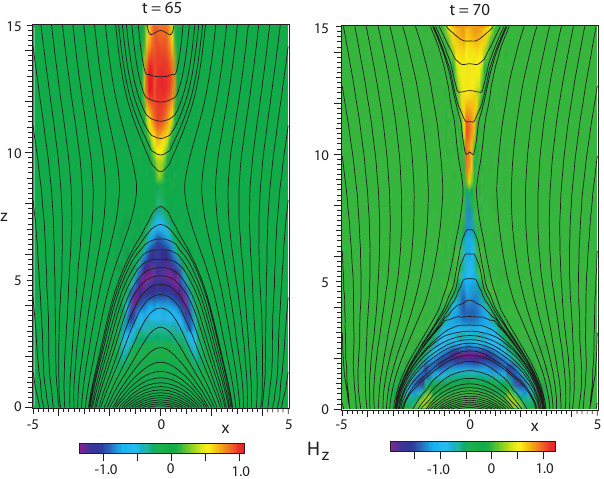
Fig. 6. Enthalpy flux H z in the x.z plane at two successive times for a high- β case, demonstrating the association between the enthalpy flux transport, related to a bursty bulk flow, and the collapse of the magnetic field.